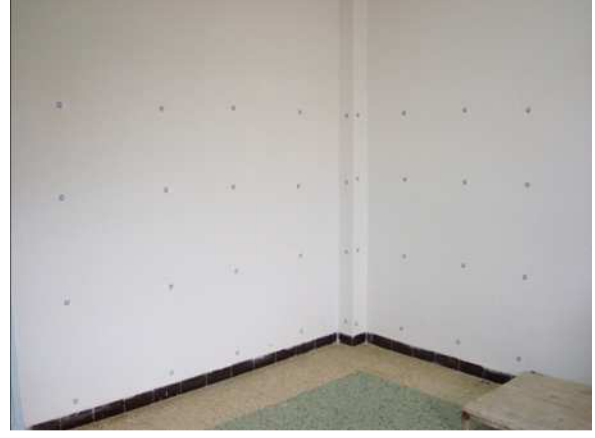
Figure 4. The calibration